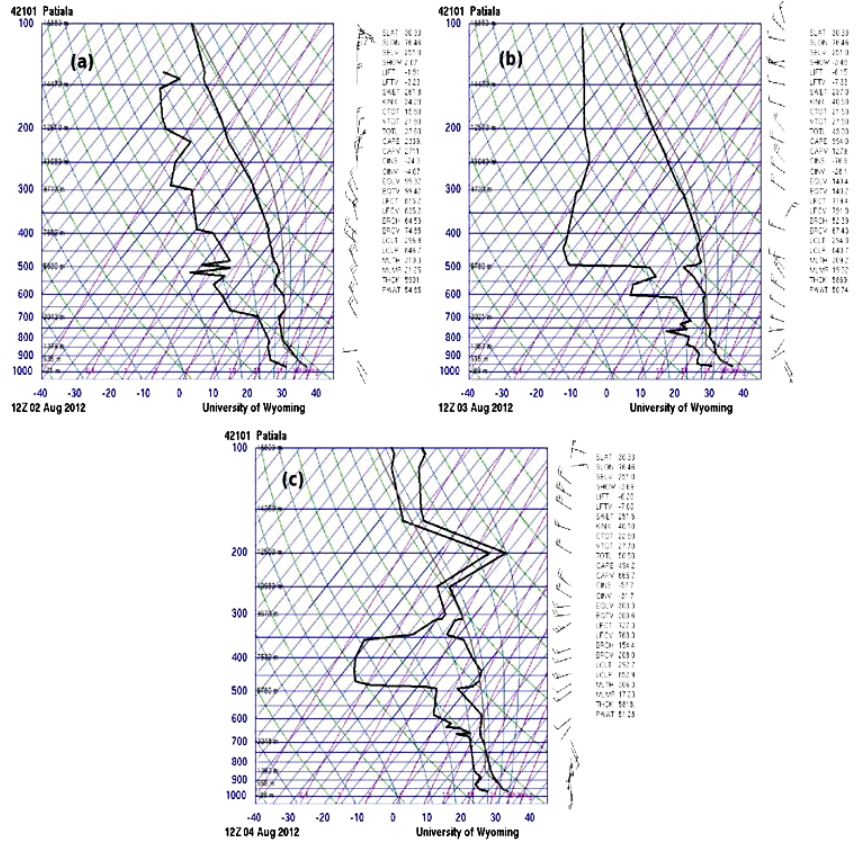
Figure 5. Radiosonde data taken at 12:00UTC on (a) 2 August, (b) 3 August, and (c) 4 August 2012 over Patiala (30.34 ◦ N, 76.38 ◦ E) near Uttarkashi (30.73 ◦ N, 78.45 ◦ E), plotted on a skew-T